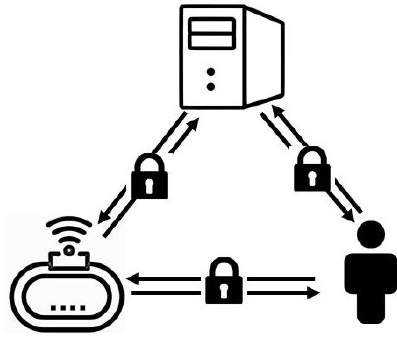
Figure 4. Secure IoT